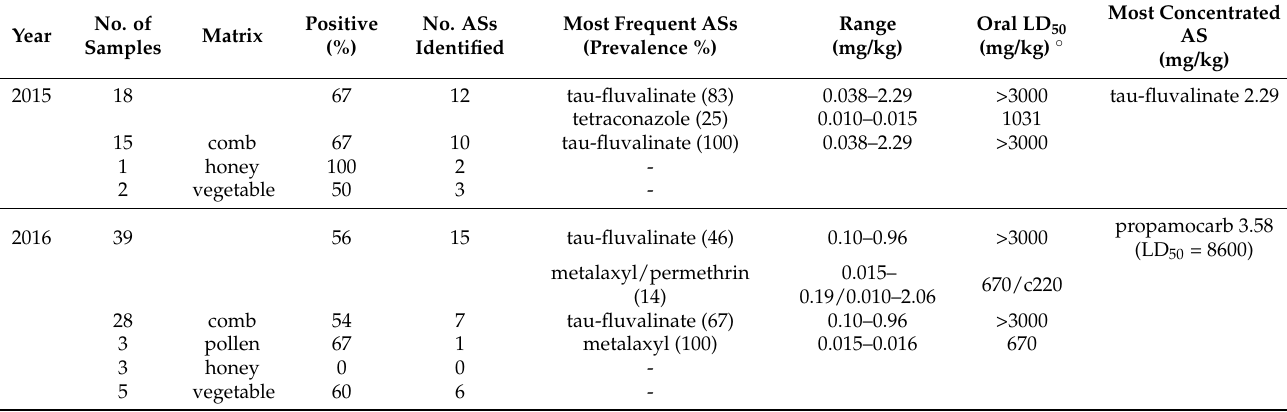
Table 2. Summary of other matrices collected from bee-killing incidents analyzed between 2015 and